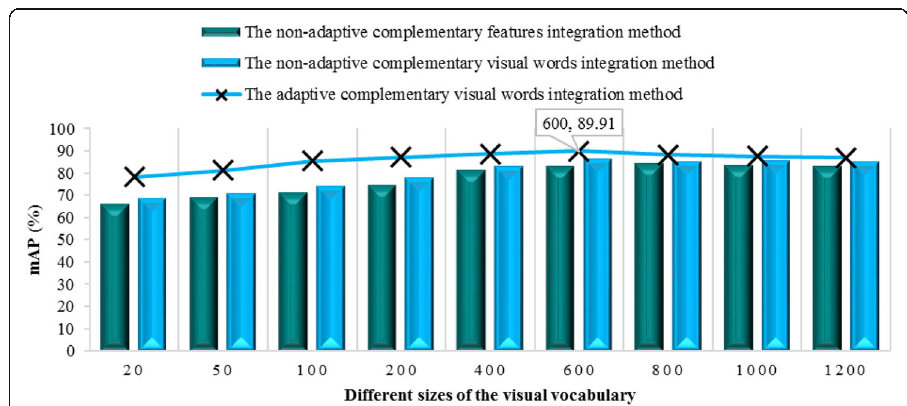
Fig. 6 Comparison of mAP of the proposed method with competitive CBIR methods on the Corel 1000 image